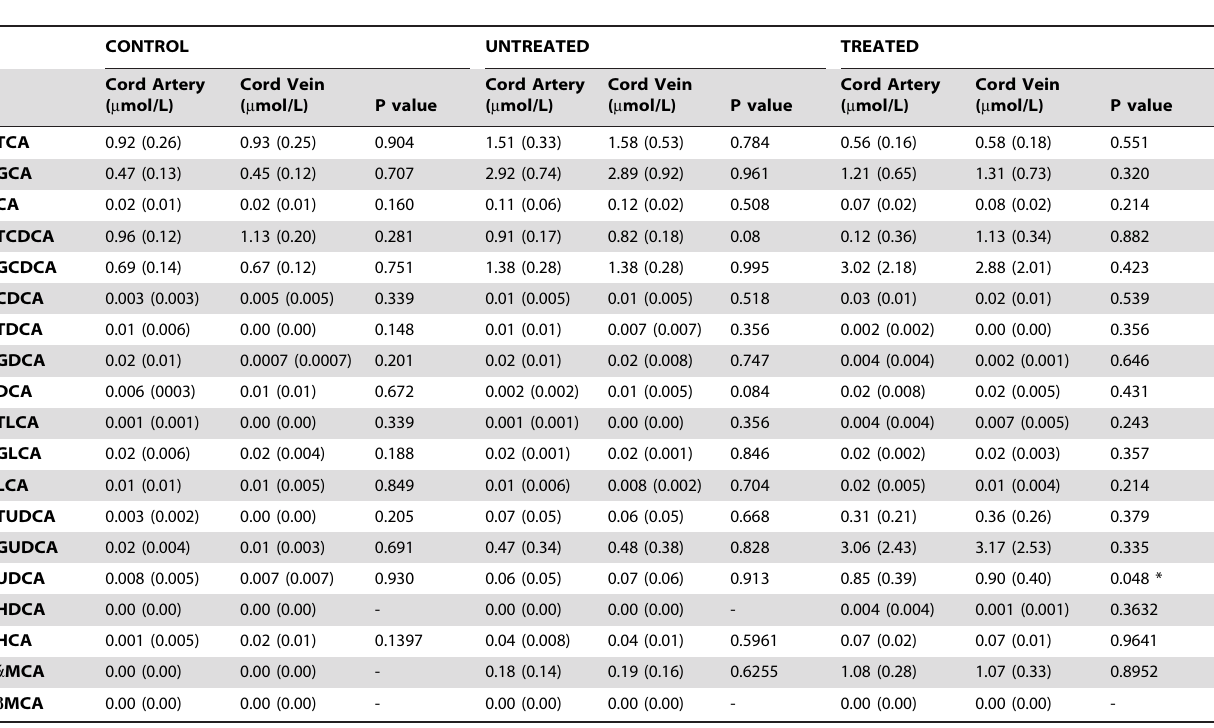
See Table 1 for abbreviations. Values represent mean (SEM).